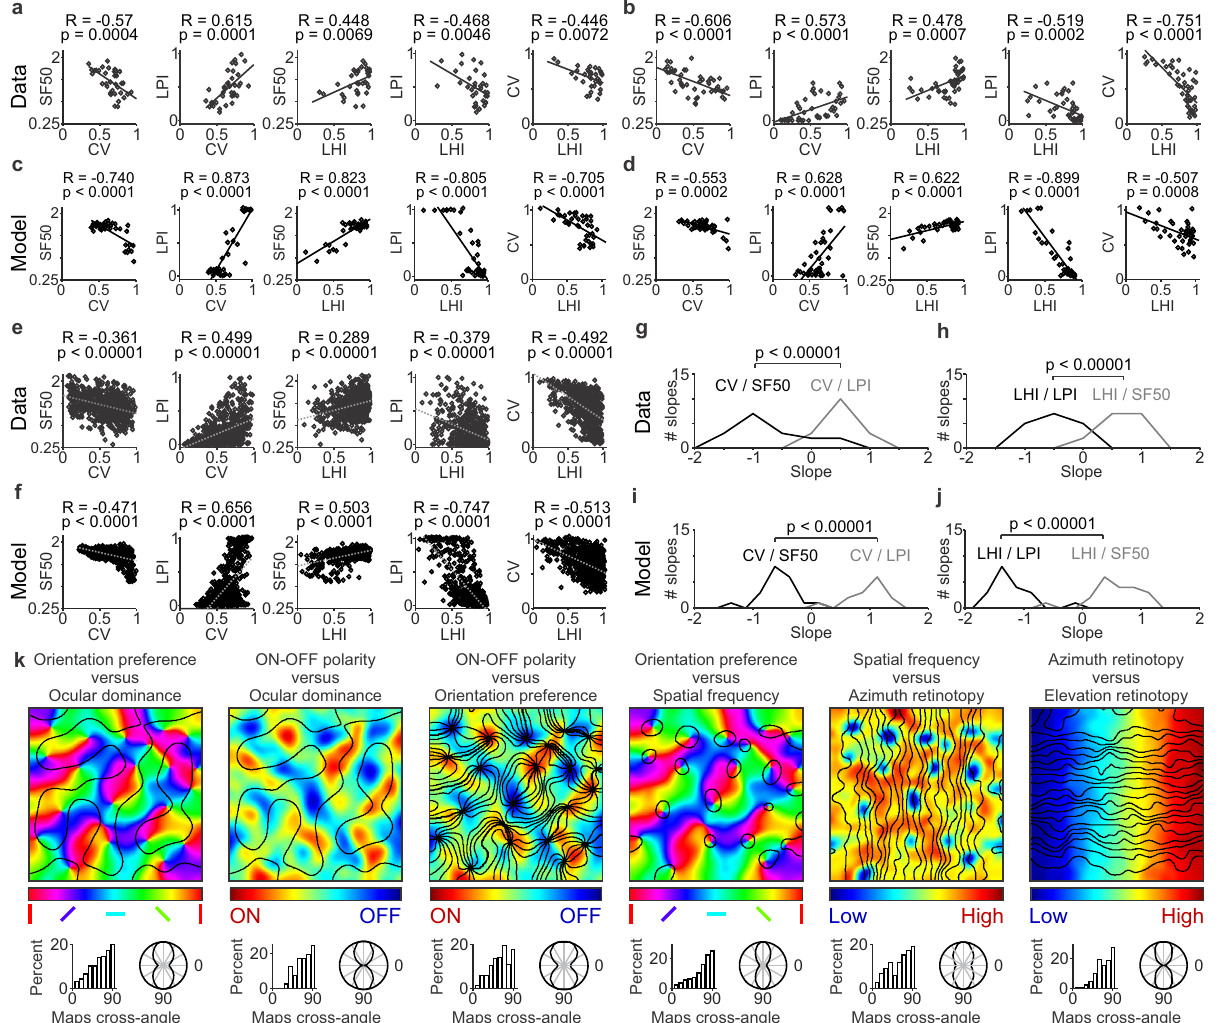
Fig. 9 Correlations among multiple stimulus parameters represented in the visual cortical map. a Example correlations between multiple pairs of stimulus parameters measured in a single horizontal track of cat visual cortex ( n = 35), including orientation selectivity measured as circular variance (CV), spatial resolution measured as the highest spatial frequency that generates half-maximum response (SF50), response strength to low spatial frequencies measured as low-pass index (LPI), and cortical clustering of orientation preference measured as a local homogeneity index (LHI). From left to right, the fi gure shows signi fi cant correlations between pairs of stimulus parameters. In all panels, r and p values were calculated with rank correlation (Matlab ‘ corr ’ function). b Example single-track correlations measured in a different animal ( n = 47). c – d The model replicates single-track correlations as illustrated in two different simulations ( c and d ). The number of data points in each plot equals the average number of data points illustrated in ( a – b ). e Correlations from all single-track recordings obtained in multiple animals ( n = 8 animals, 17 single tracks, 633 data points). f The model replicates the experimental correlations illustrated in ( e ), n = 20 single tracks, 800 data points). g Distribution of correlation slopes measured in cat visual cortex between CV and SF50 (black line), and CV and LPI (gray line). The CV/SF50 slopes were signi fi cantly more negative than the CV/LPI slopes. h Distribution of correlation slopes measured in cat visual cortex between LHI and LPI (black line) and between LHI and SF50 (gray line). The LHI/LPI slopes were signi fi cantly more negative than the LHI/SF50 slopes ( n = 8 animals, 17 single tracks for all slope measures in g – h ). i – j The model replicates the differences in slopes measured experimentally ( n = 20 single tracks). Two-sided Wilcoxon tests for all slope comparisons. k Model simulations of the relations between paired combinations of maps. For each map combination, the top panel shows the pair of superimposed maps (color scale for the map listed fi rst and contour plot for the second). The bottom panel shows the intersection angles between the two maps in a histogram (left) and a polar plot (right). Source data are provided as a Source Data fi